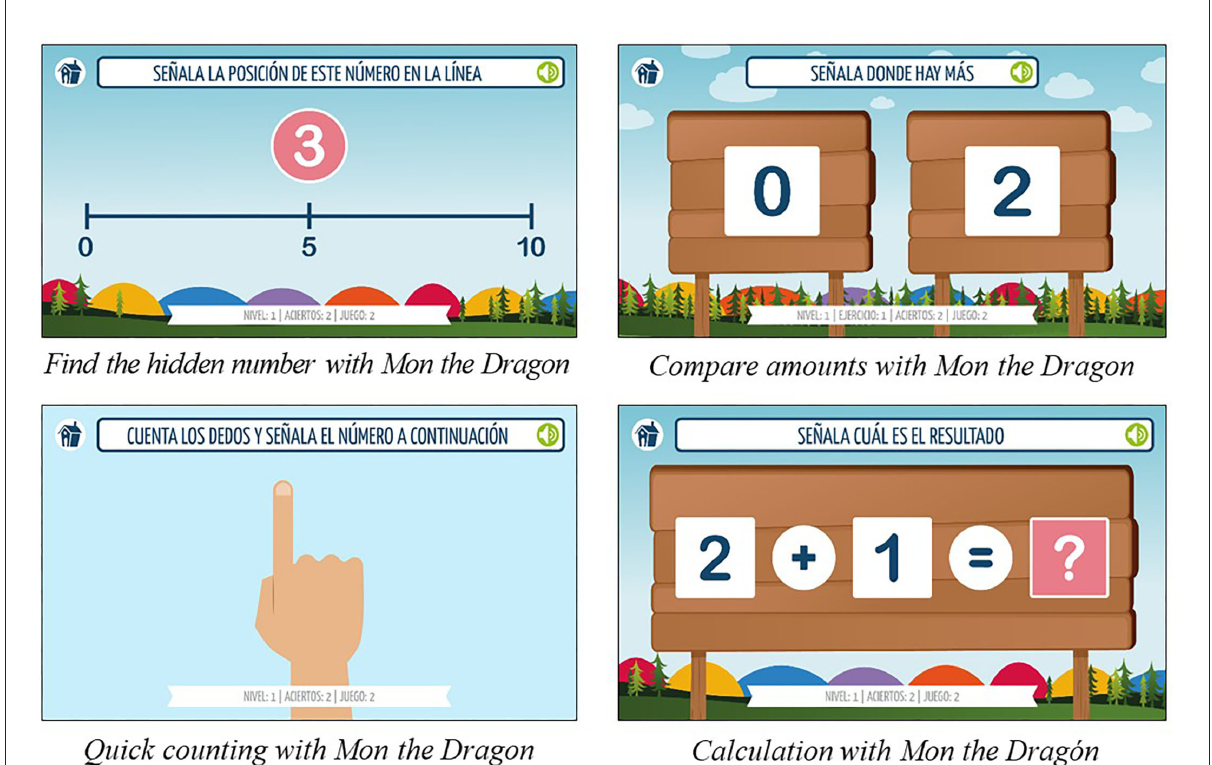
FIGURE1 Illustrations of the App designed for the